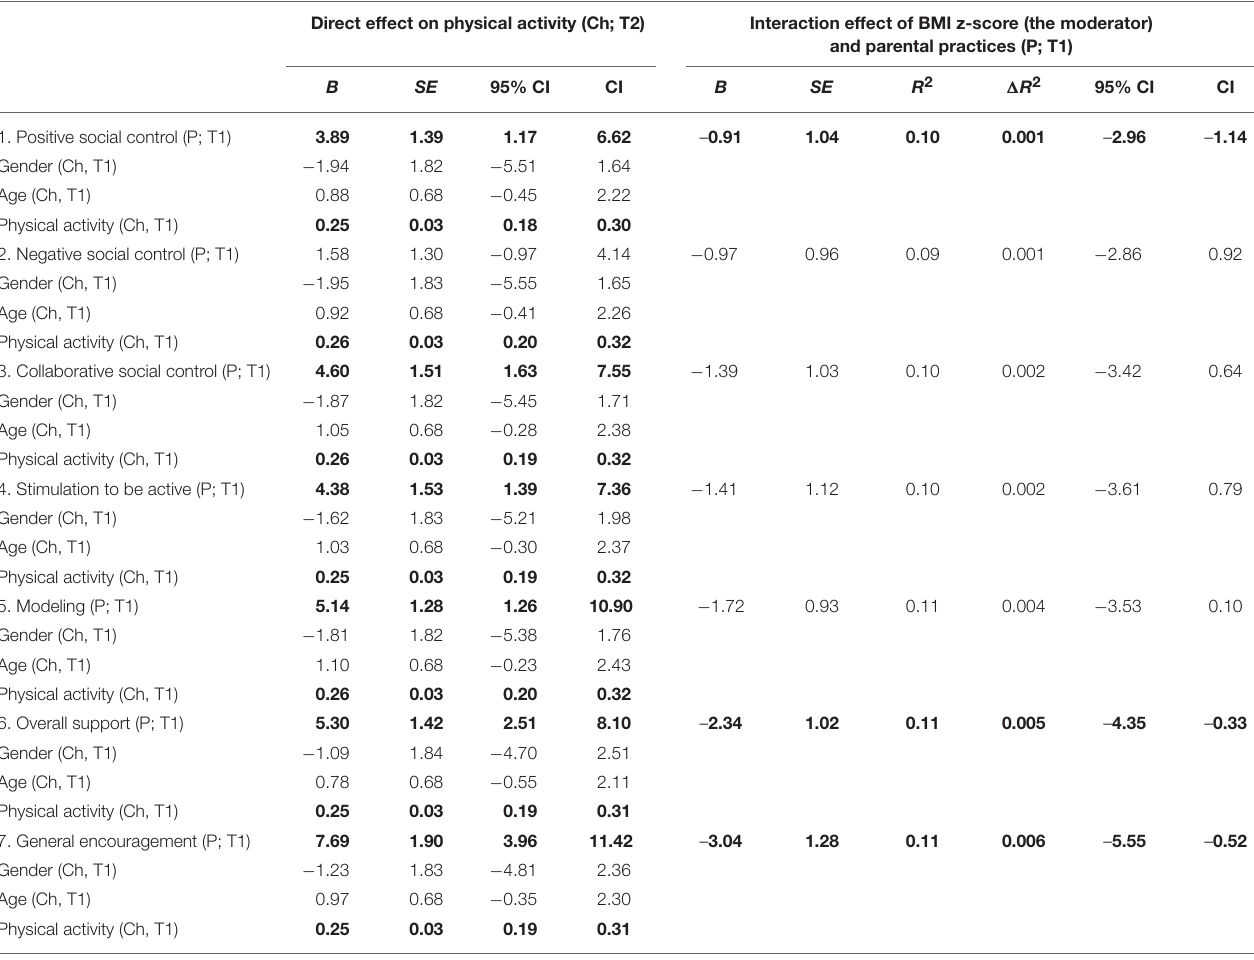
TABLE 2 | Effect of parental physical activity practices (T1) on children’s physical activity (T2) moderated by child’s BMI z-score. Direct effect on physical activity (Ch;